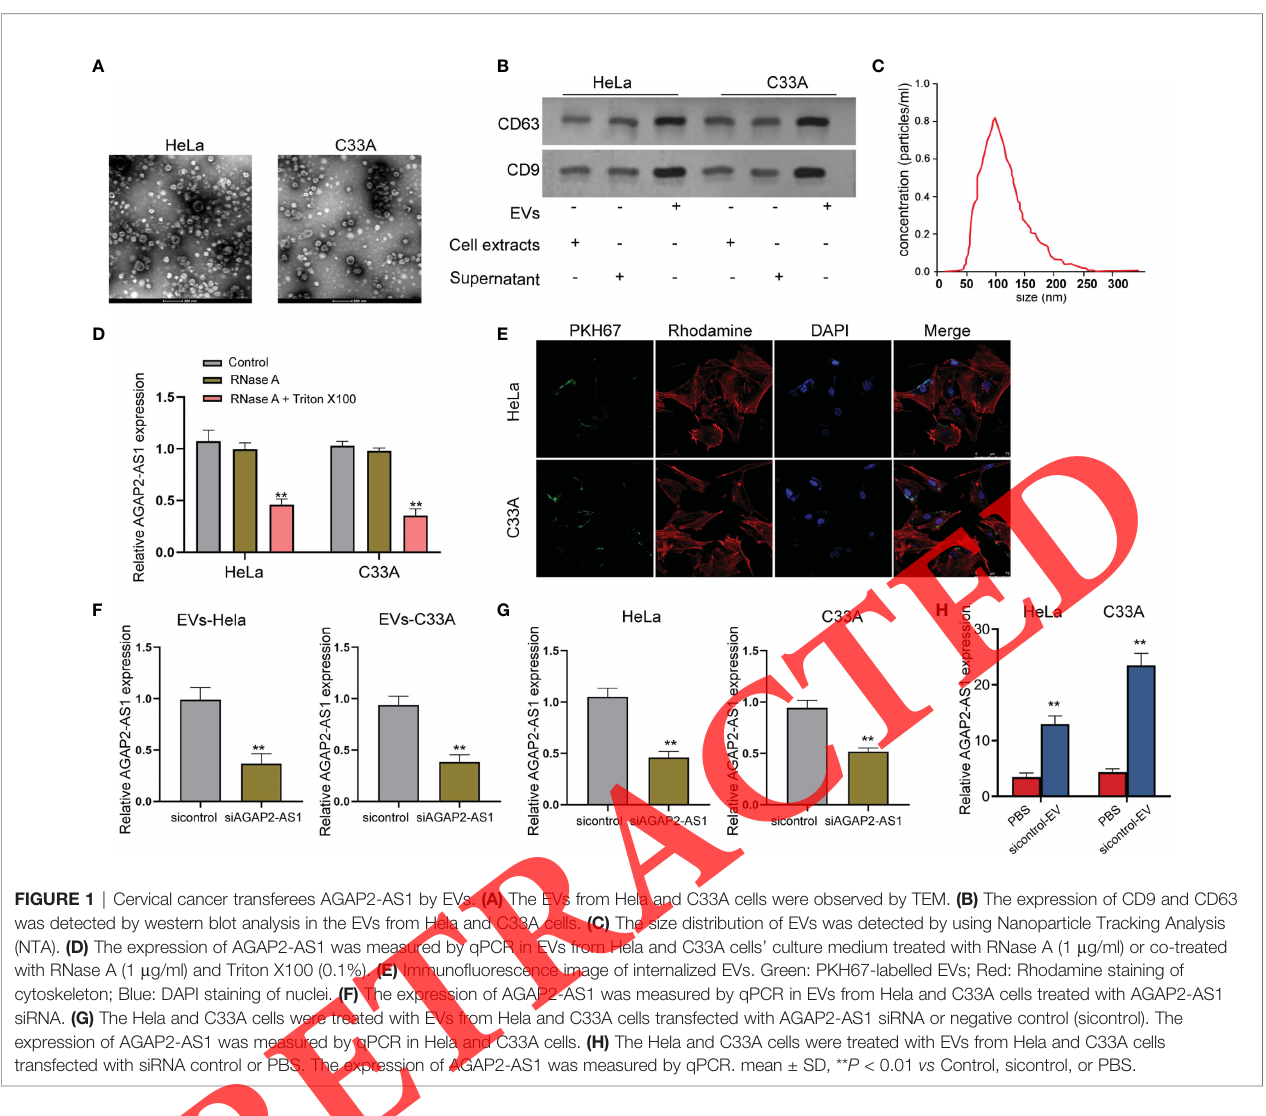
FIGURE 1 | Cervical cancer transferees AGAP2-AS1 by EVs. (A) The EVs from Hela and C33A cells were observed by TEM. (B) The expression of CD9 and CD63 was detected by western blot analysis in the EVs from Hela and C33A cells. (C) The size distribution of EVs was detected by using Nanoparticle Tracking Analysis (NTA). (D) The expression of AGAP2-AS1 was measured by qPCR in EVs from Hela and C33A cells ’ culture medium treated with RNase A (1 m g/ml) or co-treated with RNase A (1 m g/ml) and Triton X100 (0.1%). (E) Immuno fl uorescence image of internalized EVs. Green: PKH67-labelled EVs; Red: Rhodamine staining of cytoskeleton; Blue: DAPI staining of nuclei. (F) The expression of AGAP2-AS1 was measured by qPCR in EVs from Hela and C33A cells treated with AGAP2-AS1 siRNA. (G) The Hela and C33A cells were treated with EVs from Hela and C33A cells transfected with AGAP2-AS1 siRNA or negative control (sicontrol). The expression of AGAP2-AS1 was measured by qPCR in Hela and C33A cells. (H) The Hela and C33A cells were treated with EVs from Hela and C33A cells transfected with siRNA control or PBS. The expression of AGAP2-AS1 was measured by qPCR. mean ± SD, ** P < 0.01 vs Control, sicontrol, or